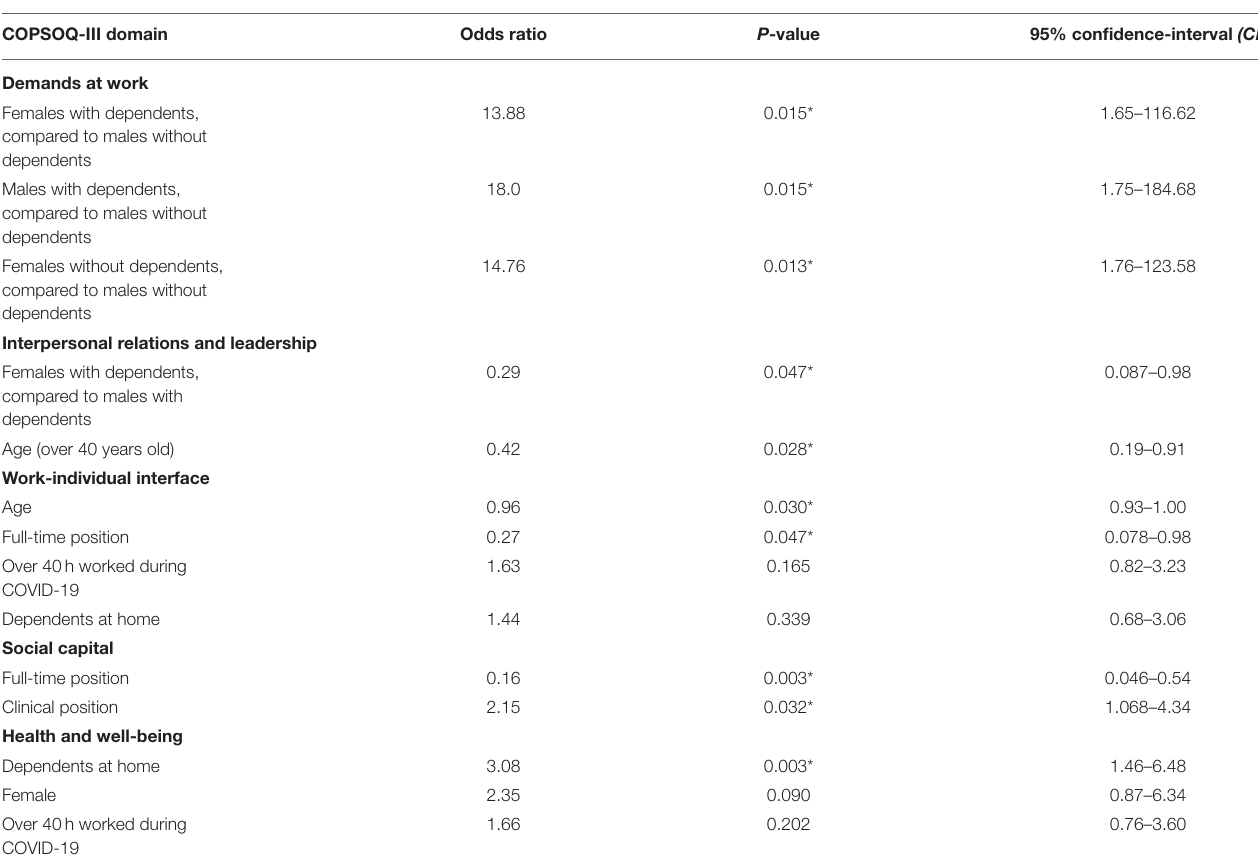
TABLE 6 | Logistic regressions for reporting worsened COPSOQ-III domains with explanatory variables of full-time position, dependents at home, gender, clinical position, age, and hours worked per week during the COVID-19 restrictions. COPSOQ-III